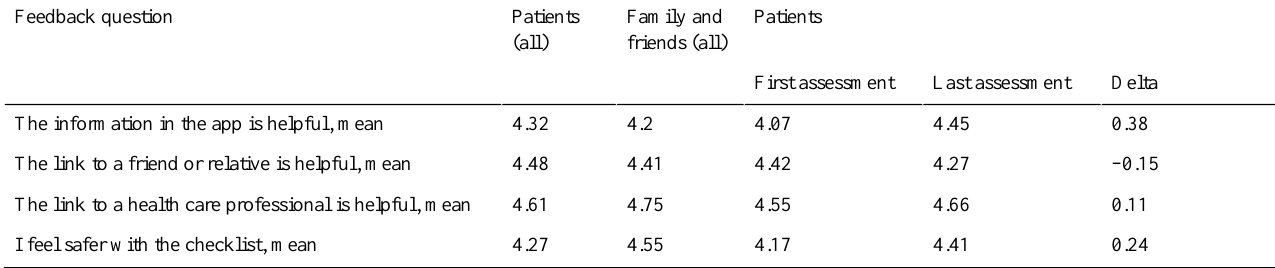
PatientsFamily and (all)Patients (all)Feedback question friends